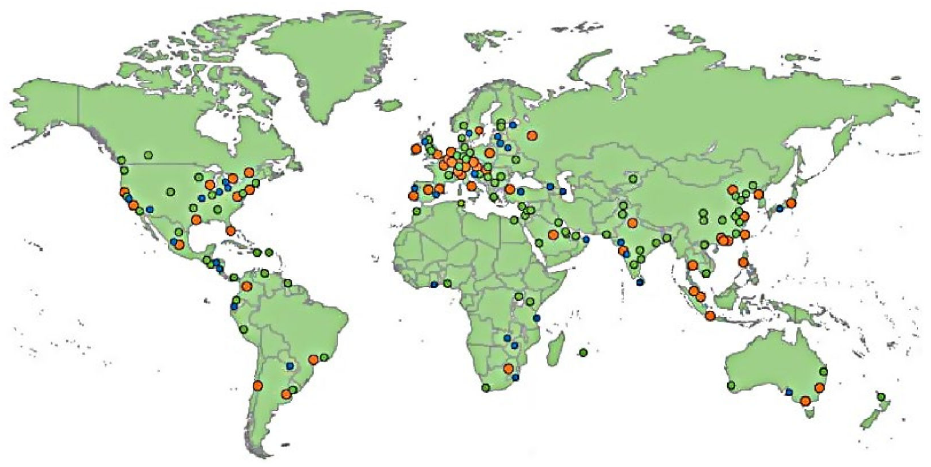
Figure 6. GaWC Global Cities Scheme (orange—alpha cities; green—beta cities; blue—gamma cities)